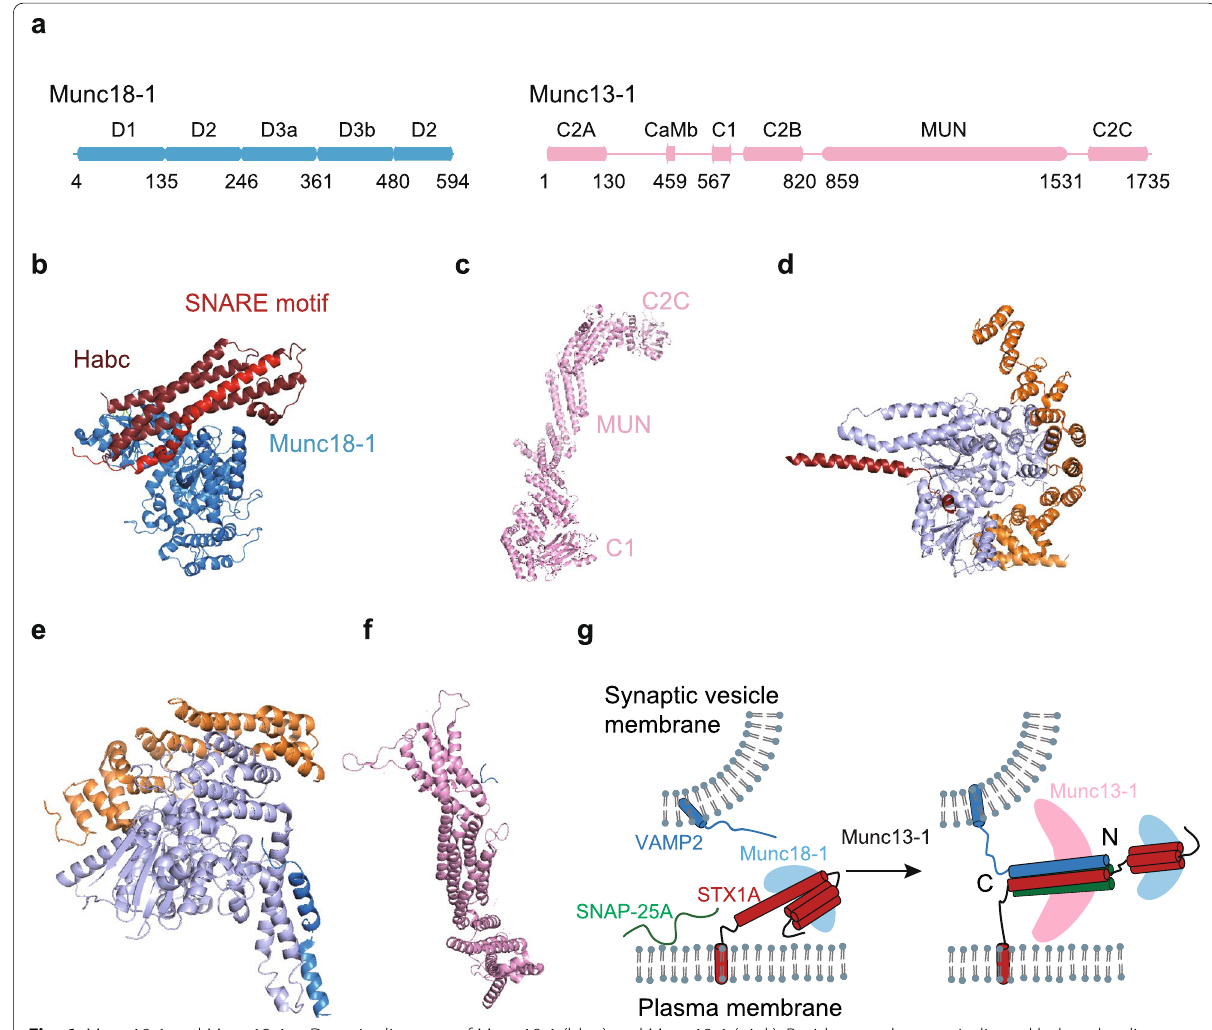
Fig. 6 Munc18-1 and Munc13-1. a Domain diagrams of Munc18-1 (blue) and Munc13-1 (pink). Residue numbers are indicated below the diagrams. b Crystal structure of the STX1A-Munc18-1 complex in Rattus norvegicus (PDB ID: 3C98) [218]. The Habc domain (dark red) of STX1A locks the SNARE motifs (red) in the closed conformation by the interaction of Munc18-1. c Cryo-EM crystal structure of the C1C2BMUNC2C fragment of Munc13-1 in Rattus norvegicus (PDB ID: 7T7V) [334]. d Crystal structure of the Qa-SNARE Vam3 (red) bound to the SM protein Vps33 (light blue) in Chaetomium thermophilum (PDB ID: 5BUZ) [321]. e Crystal structure of the R-SNARE Nyv1 (marine) bound to the SM protein Vps33 in Chaetomium thermophilum (PDB ID: 5BV0) [321]. f Crystal structure of the VAMP2 (marine, residues 87–92)-MUN (pink) complex in Rattus norvegicus . (PDB ID: 6A30) [333]. g Model of Munc13-1 (pink) catalyzing the transfer of STX1A from the Munc18-1 (light blue)-STX1A complex to the properly assembled ternary trans- SNARE complex. The color codes for STX1A, SNAP-25A and VAMP2, are red, green, and blue,